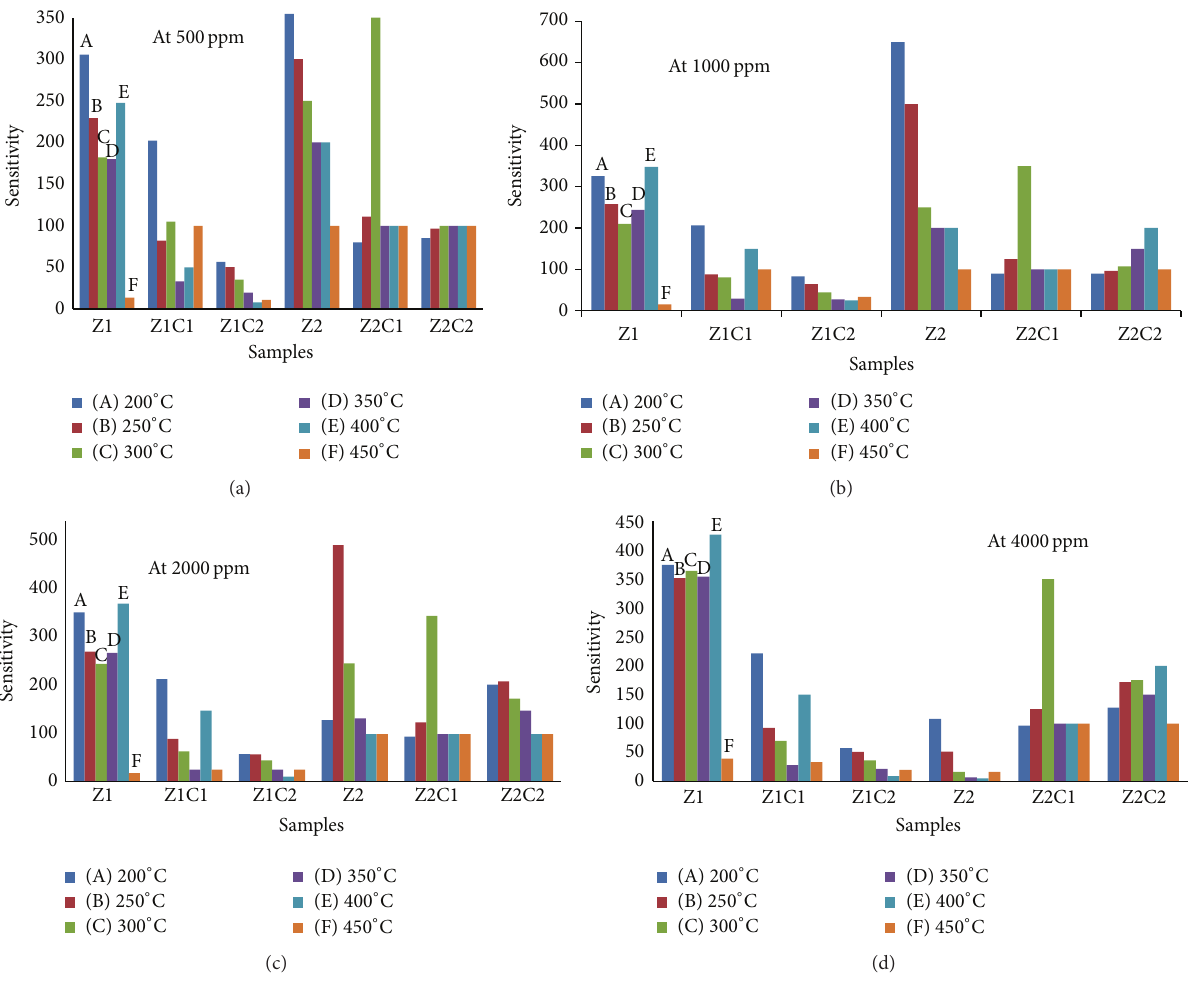
Figure 10: (a) Variation of sensitivity of undoped and Cu doped ZnO thin film samples at 500 ppm CO 2 concentration with temperature. (b) Variation of sensitivity of undoped and Cu doped ZnO thin films sample at 1000ppm CO 2 concentrations with temperature. (c) Variation of sensitivity of undoped and Cu doped ZnO thin films sample at 2000 ppm CO 2 concentrations with temperature. (d) Variation of sensitivity of undoped and Cu doped ZnO thin film samples at 4000 ppm CO 2 concentration with temperature.